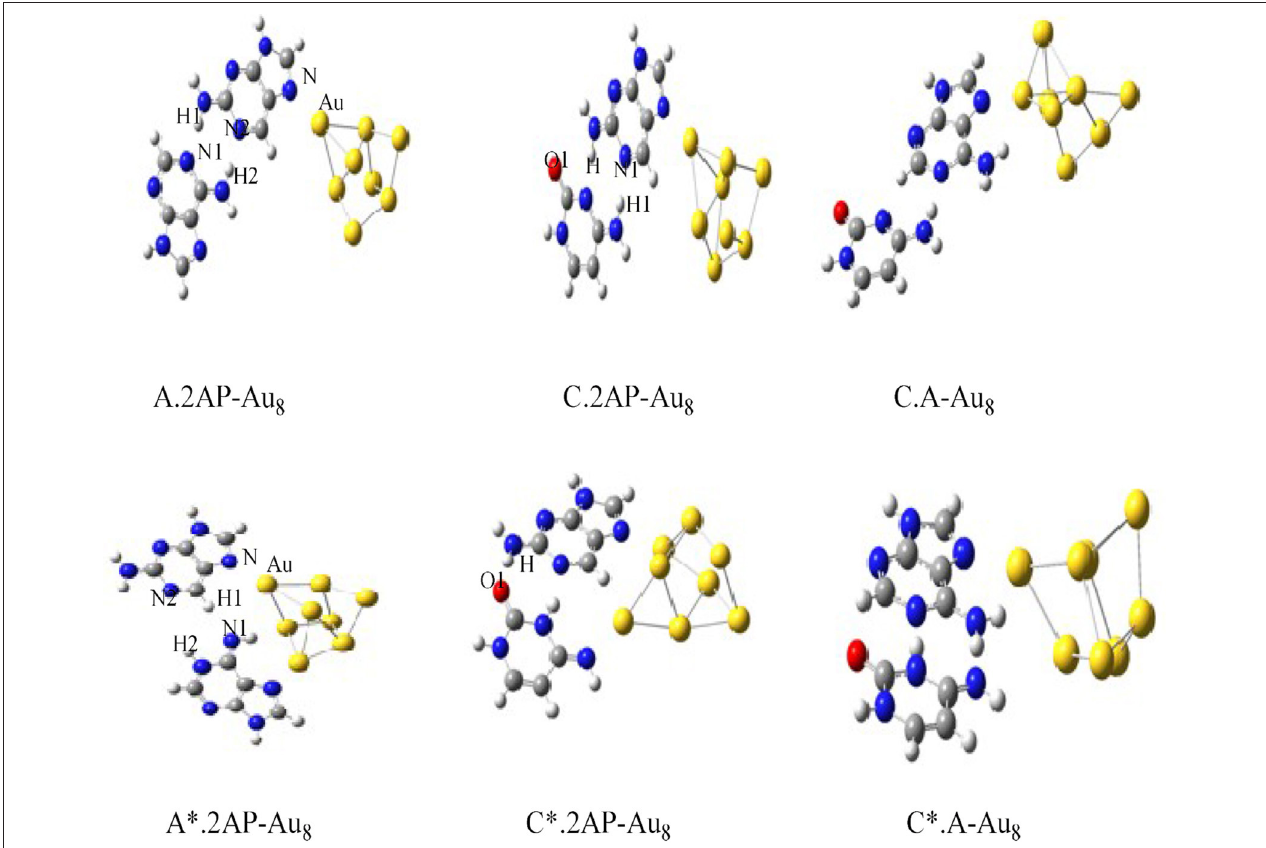
FIGURE 6 | Optimized structures of [A.2AP(w)/A*.2AP(WC)/C.2AP(w)/C*.2AP(WC)/C.A(w)/C*.A(WC)]–Au 8 complexes (Adapted with permission from Taylor and Francis).